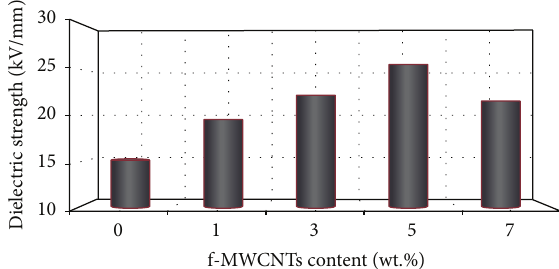
Figure 12: Effect of f-MWCNTs on dielectric strength of nanocom- posites.